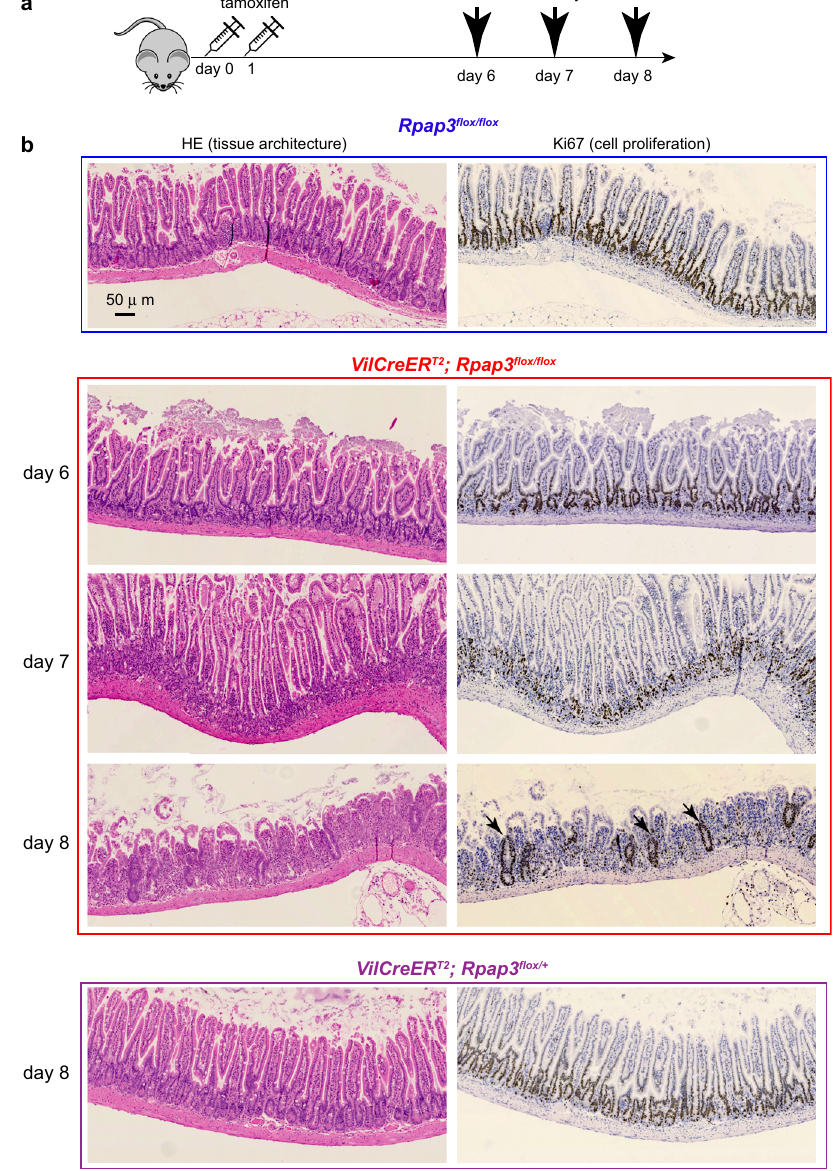
Fig. 2 Rpap3 is necessary to small intestine integrity. a Schematic representation of the experimental setting: 8-week-old mice of the indicated genotype received two sequential injections of tamoxifen 24 h apart, and were analyzed 6 to 8 days after the fi rst injection. b Pictures of jejunum tissue sections stained with HE (left) or by IHC with anti-Ki67 antibodies (right panels — Ki67 signal is brown) at different days after the fi rst tamoxifen injection. Black arrowheads indicate remnants of crypt glands with Ki67 + cells observed at day 8. Scale bar is identical for all panels, and is 50 μ m as shown in control HE panel. Each panel is representative of 8 to 12 animals from three independent